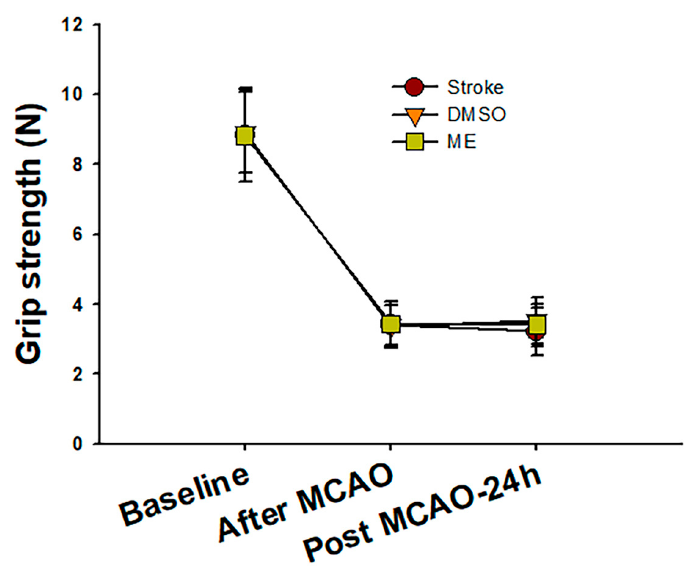
Figure 6. The change in rat grip strength during the experimental period. Rat grip strength dramatically decreased more than 50% compared to the baseline in all three groups after middle cerebral artery occlusion (MCAO) surgery. After 24 h of magnolol (30 mg / kg) treatment, the DMSO and ME groups showed a slight but non-significant grip strength increase compared to the stroke group. Data are expressed as mean ± SD of six independent experiments. Pharmaceutics 2020 , 12 , x FOR PEER REVIEW